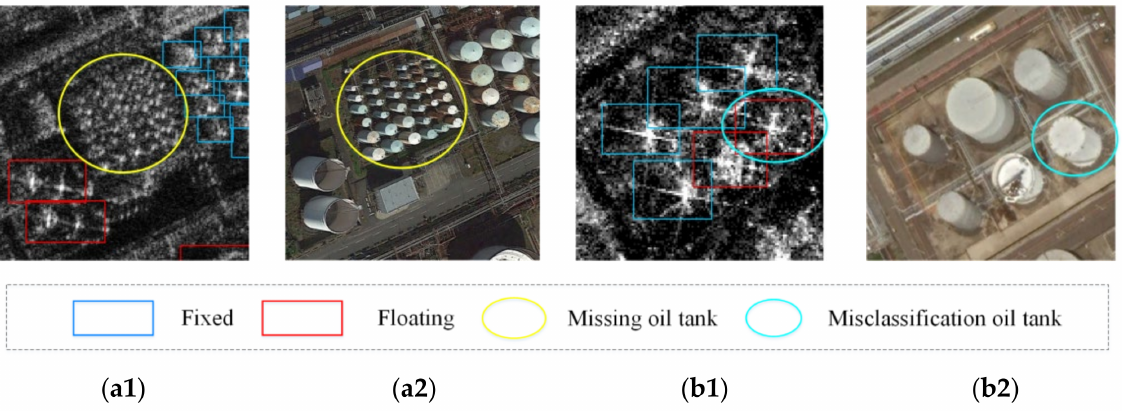
Figure 11. ( a1 ) Missing detections of oil tanks less than 10 m in diameter on an SAR image. ( a2 ) Optical image from Google Earth of ( a1 ). ( b1 ) Misclassification of oil tanks on a poorly focused SAR image. ( b2 ) Optical image from Google Earth of ( b1